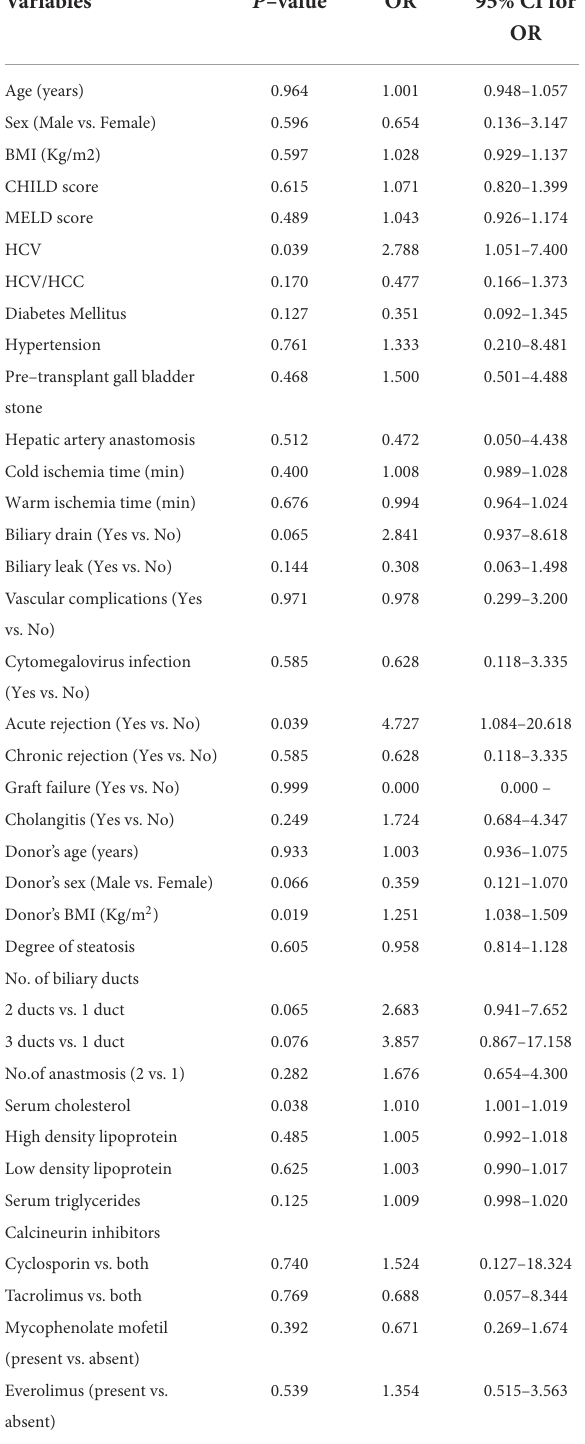
TABLE 8 Backward elimination, multivariate logistic regression analysis for determining independent risk factors of developing biliary stones post–LDLT (total n =